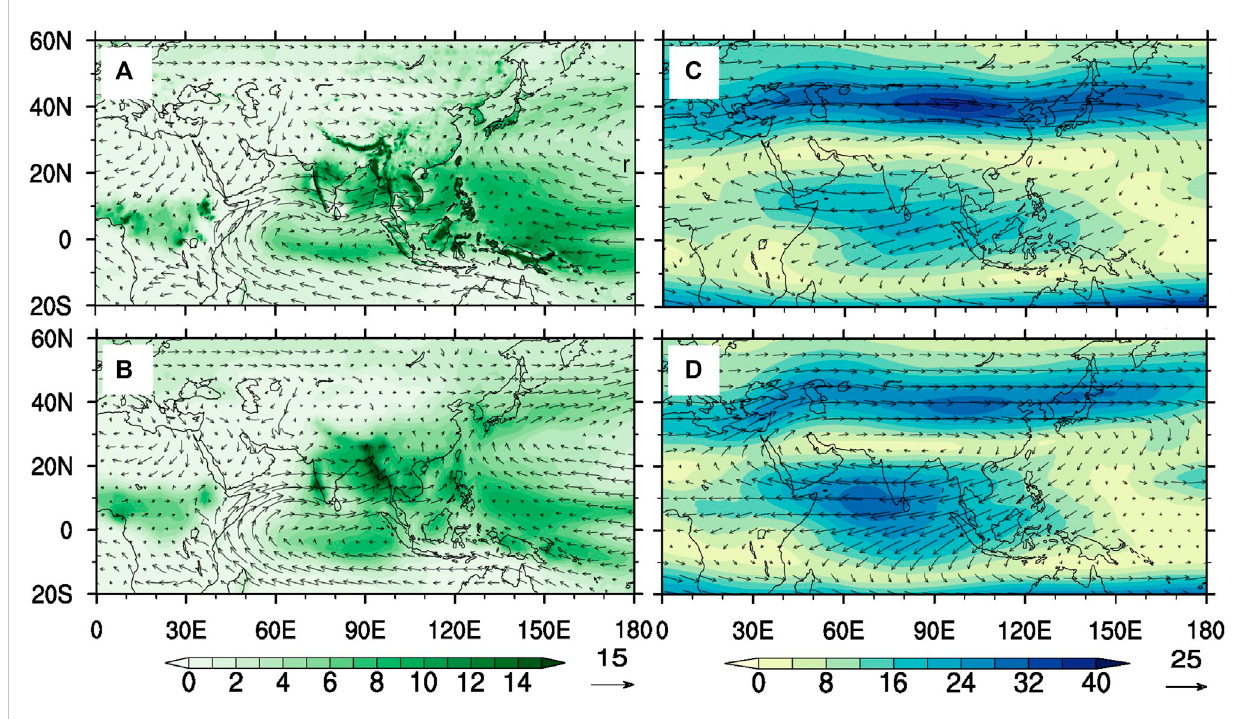
FIGURE 2 SpatialmapofJJAStime-mean(1979 – 2005)precipitation(mmday -1 )(shaded)and850 hPawinds(ms -1 )(vector): (A) HIST (B) GPCPandERA5 (C –